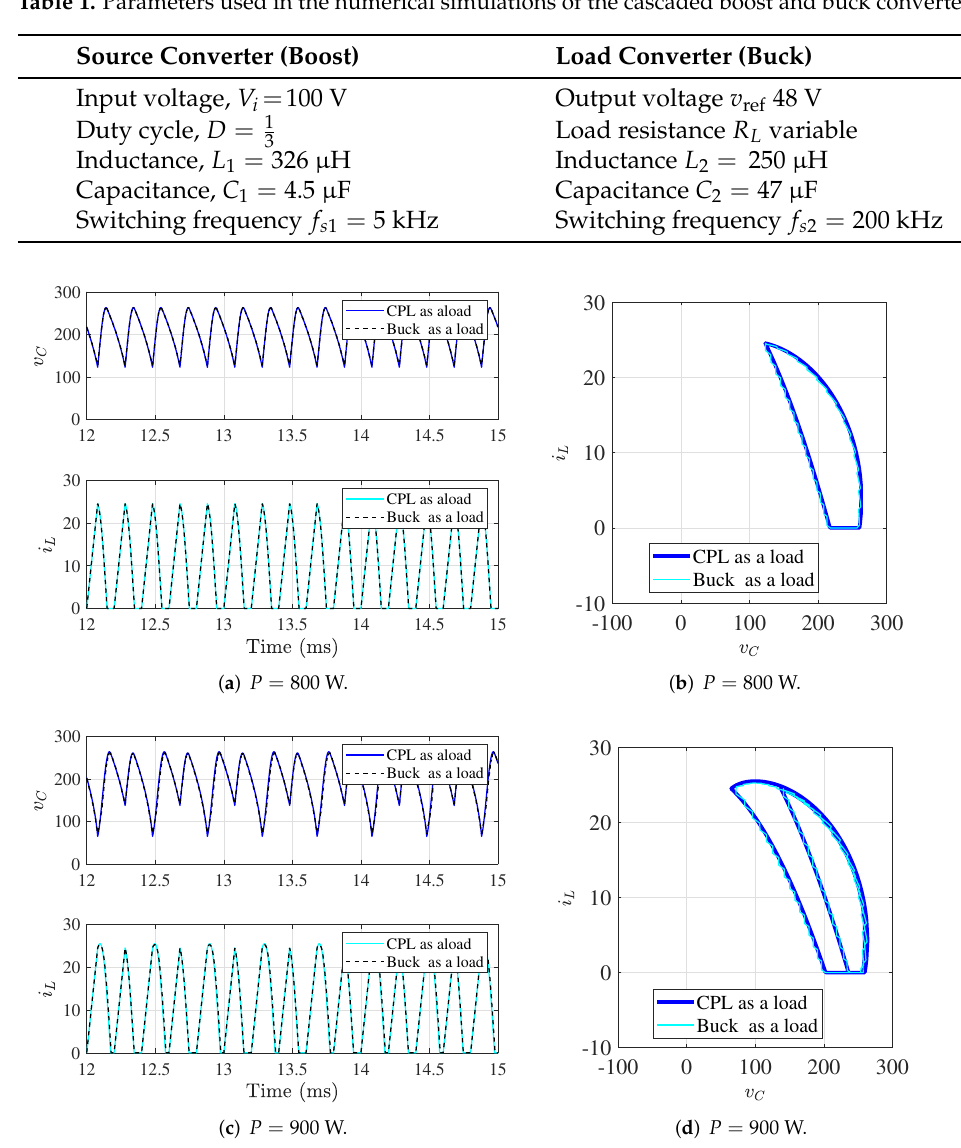
Figure 2. Behavior of an open loop boost converter operating in DCM loaded by a tightly regulated − buck converter and by an ideal CPL. ( a , b ) P = 800 W: stable periodic regime, ( c , d ) P = 900 W: subharmonic